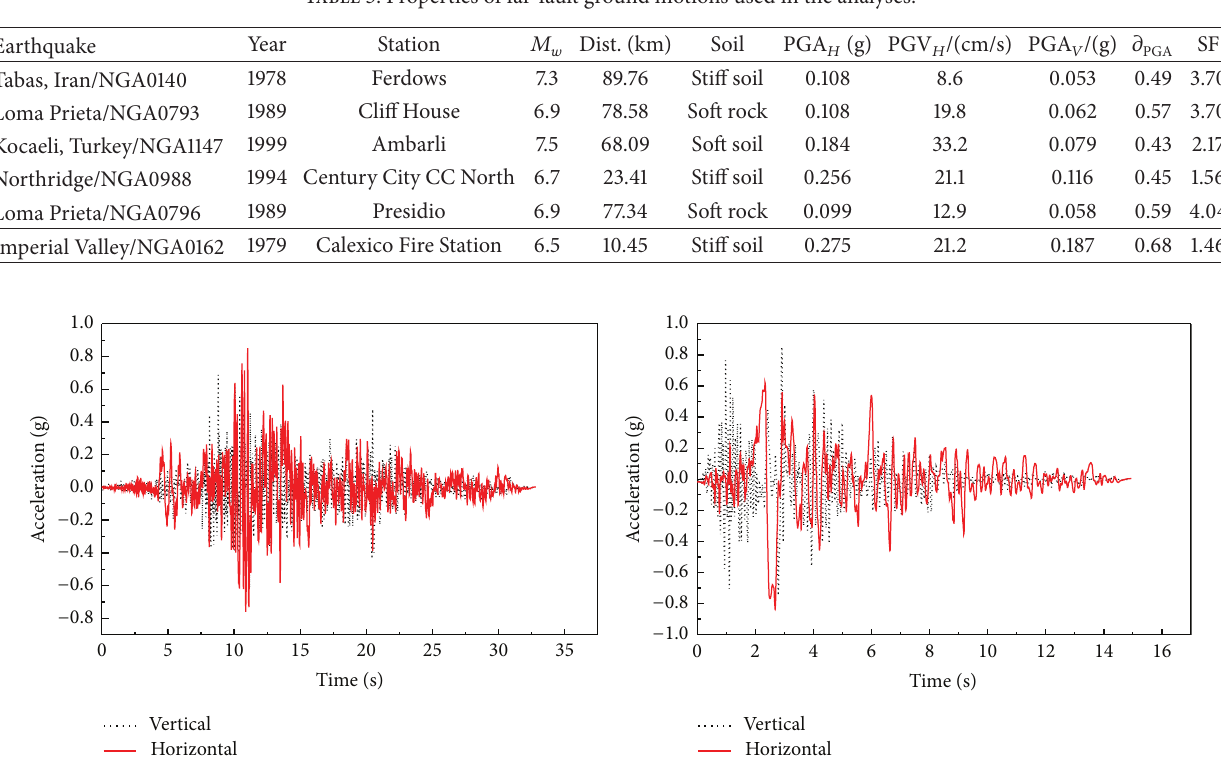
(b) Vertical and horizontal motions of Northridge earthquake, 1978, record from Rinaadi station Figure 7: Vertical and horizontal motions of Tabas and Northridge